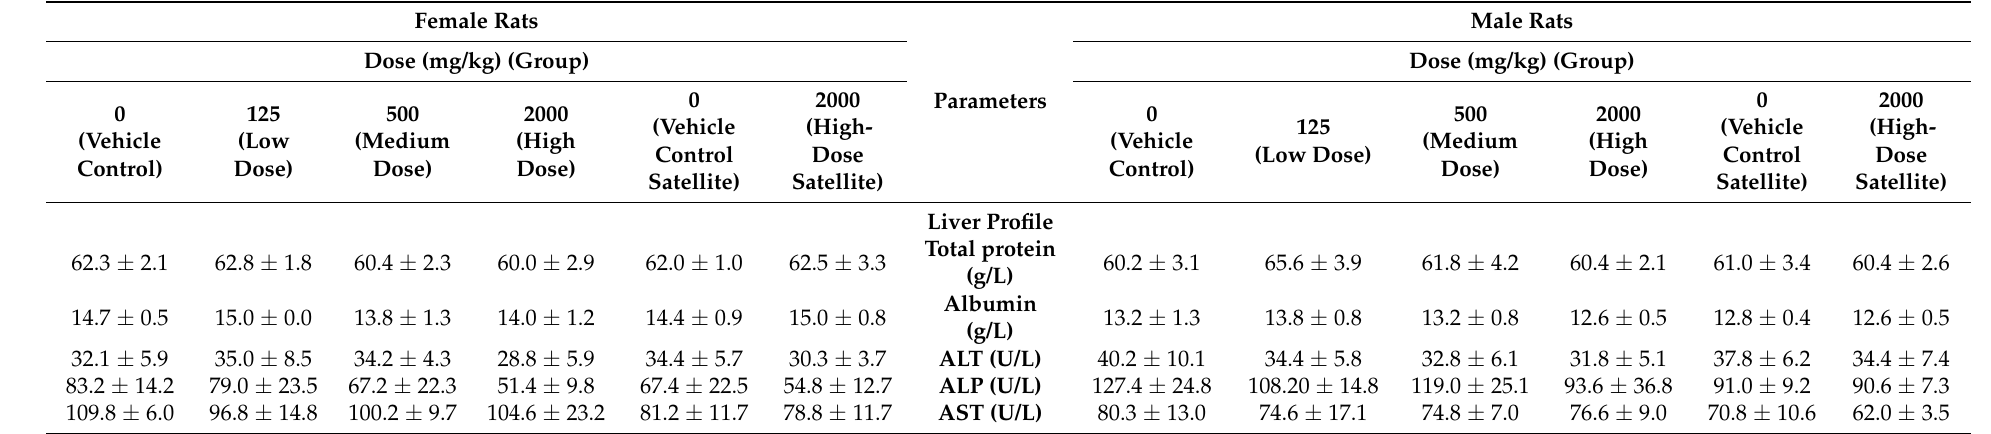
Table 7. Clinical biochemistry liver profile parameter in female and male